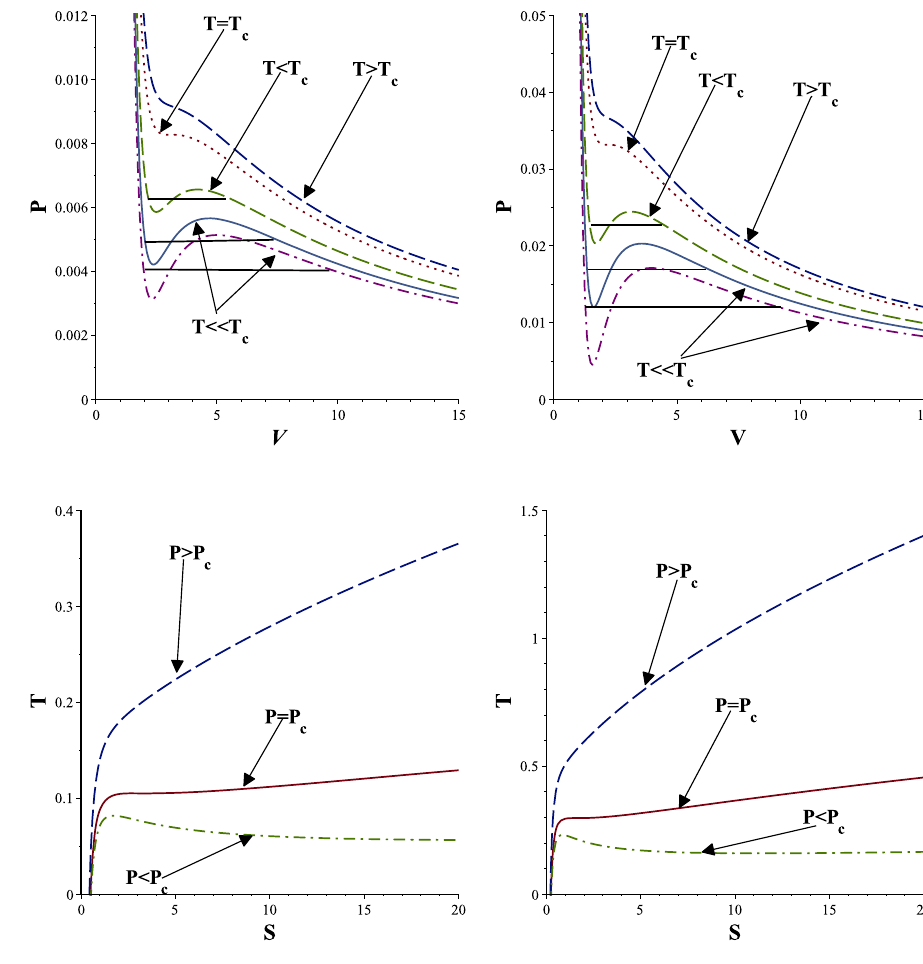
Fig. 2 P – V plot of dynamic phantom AdS BH with e = 0 . 2, g = 0 . 6, a 2 = 1 (left) and a 2 = 2 (right). In both graphs the isotherm decreases from top to bottom. The zeroth and first order phase transition are characterized different colors. The isobar (black thin line) remedy unphysical locally and globally unstable regime